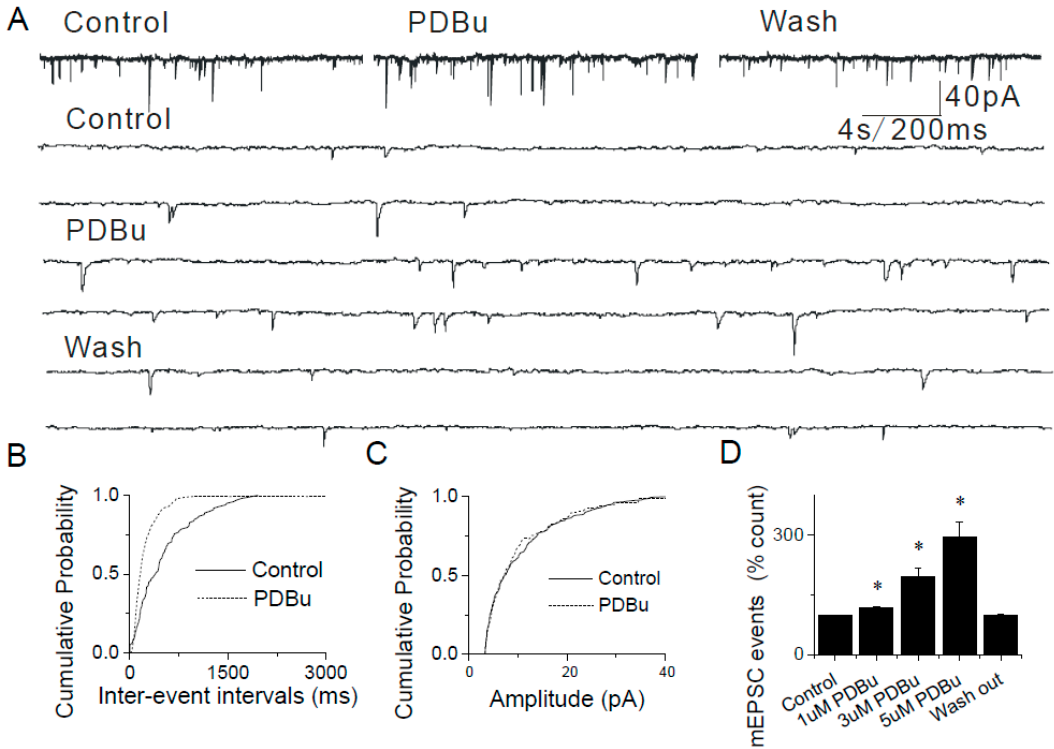
Figure 6. Modulation of synaptic transmission in the NTS by phorbol-12,13-dibutyrate (PDBu). ( A ) PDBu increases the frequency of mEPSCs in a reversible manner. Synaptic currents are shown in higher time resolution below. ( B , C ) Cumulative probability graphs showing enhanced frequency of mEPSCs ( p < 0.001,KS test) in response to PDBu without change in their amplitudes. ( D ) Summary graphs showing that PDBu-mediated increase in mEPSCs (1 µ M, 117.84 ± 19.66%, n = 6; 3 µ M, 195.76 ± 30.15%, n = 5, * p < 0.01; 5 µ M, 295.13 ± 38.57%, n = 6, * p < 0.01). The asterisk (*) represents p < 0.05 as compared to control.